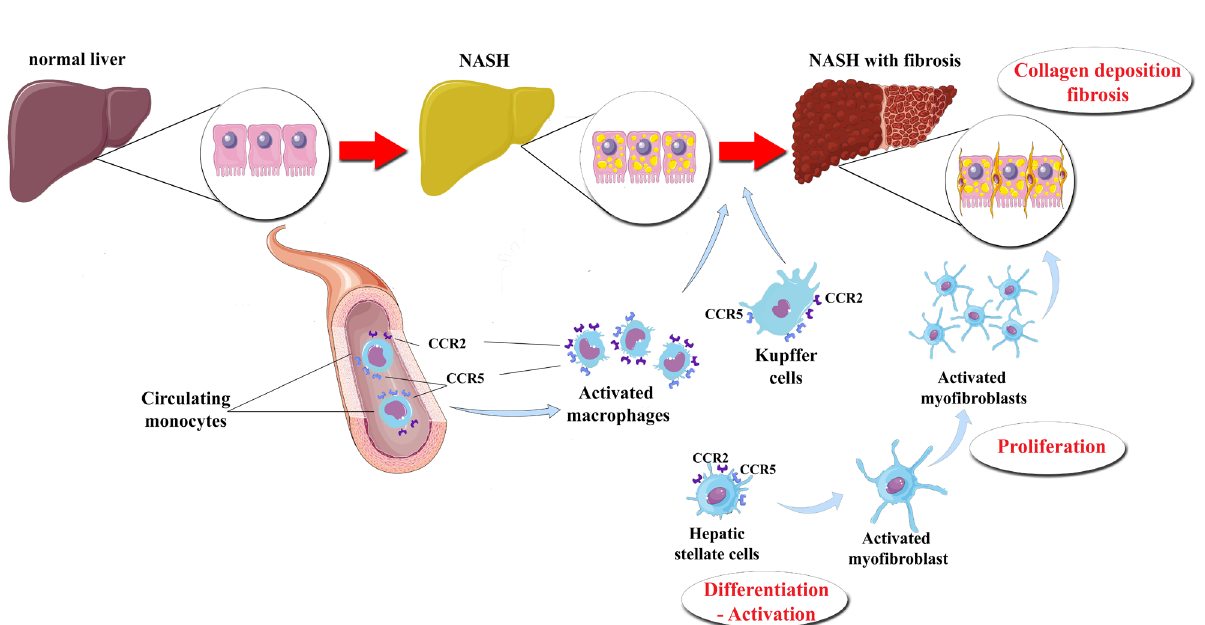
liver may subsequently progress to steatosis, inflammation and fibrosis. The activation of CCR2 and CCR5, which are possibly located on the Kupffer cells * , macrophages infiltrating the liver and HSCs, may result in their transformation and activation. Thus, hepatic inflammation and fibrosis are initiated and propagated. CVC is a dual CCR2 and CCR5 antagonist that seems to attenuate the activation of Kupffer cells, infiltrating macrophages, and HSCs, thus possibly mitigating hepatic inflammation and fibrosis. * CCR2 may be expressed in Kupffer cells of animal models, whereas CCR2 may not be expressed or may be not functional in human Kupffer